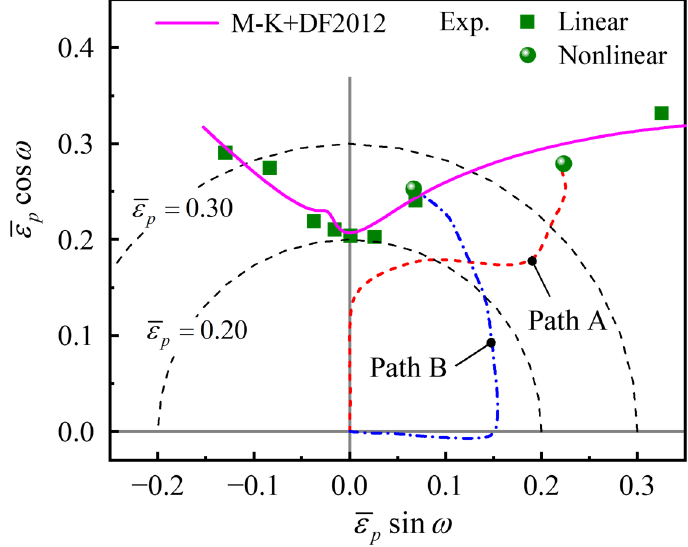
Figure 12. Comparison of predicted PEPS-FLC and experimental limit strains of the AA6061 tube.